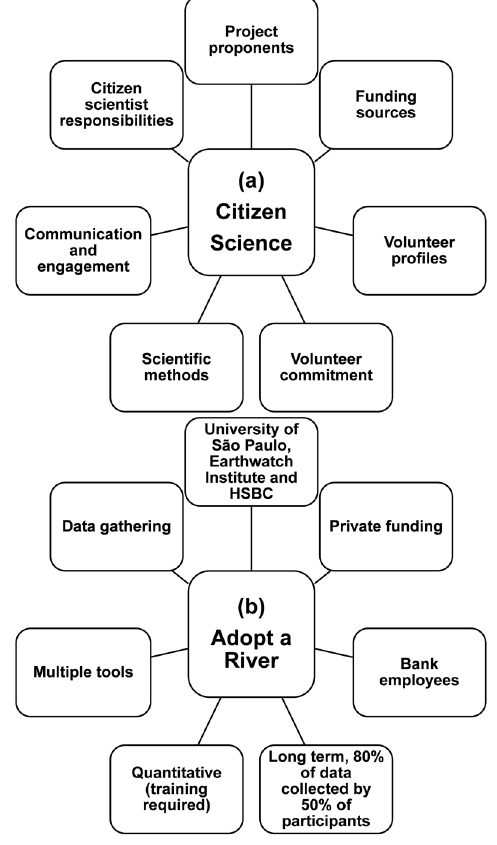
Figure 6 - Seven elements related to project structure and participants in the analyzed citizen science projects ( a ) and in the “Adopt a River” project ( b